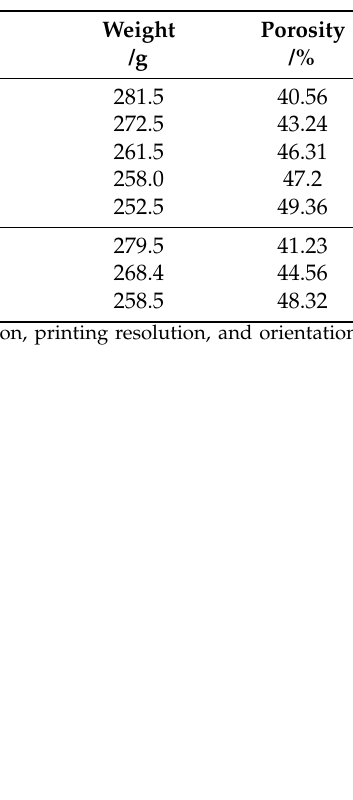
Figure 7. Comparison of porosity and density of the 3DP rocks printed with different blends of sand